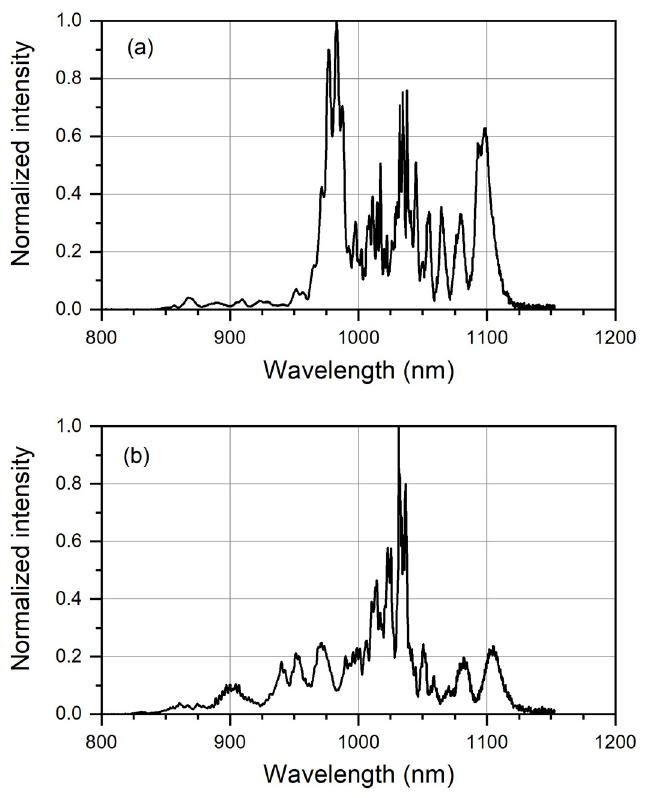
Figure 4. Typical spectra measured at the revolver fiber output for ( a ) xenon pressure of 15 atm and input pulse energy of 3.8 μJ, and ( b ) xenon pressure of 40 atm and input pulse energy of 1.5 μJ.